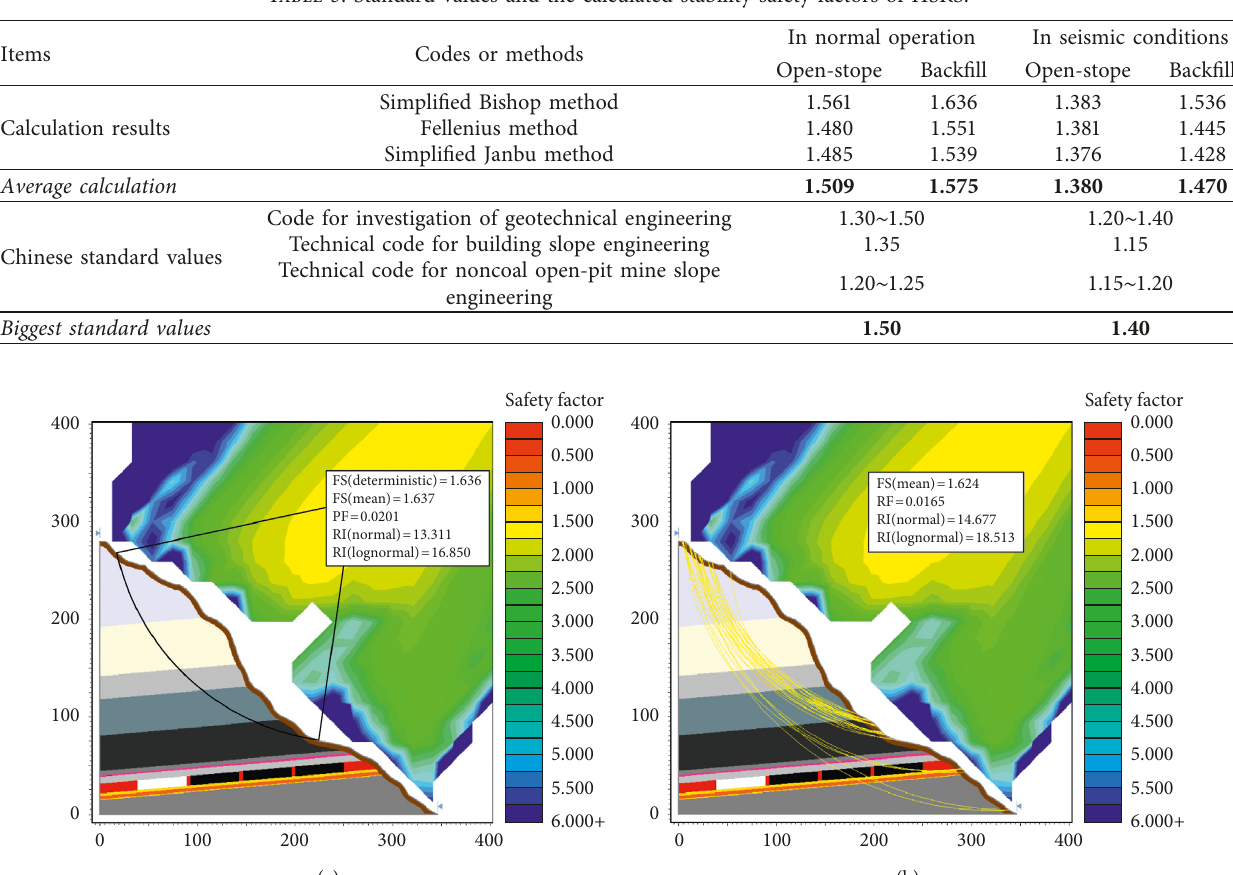
Table 5: Standard values and the calculated stability safety factors of HSRS.